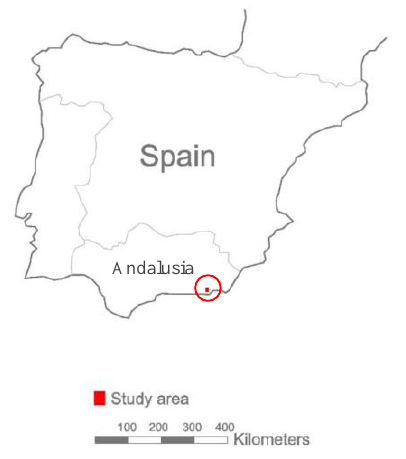
Figure 1 . Location of the study